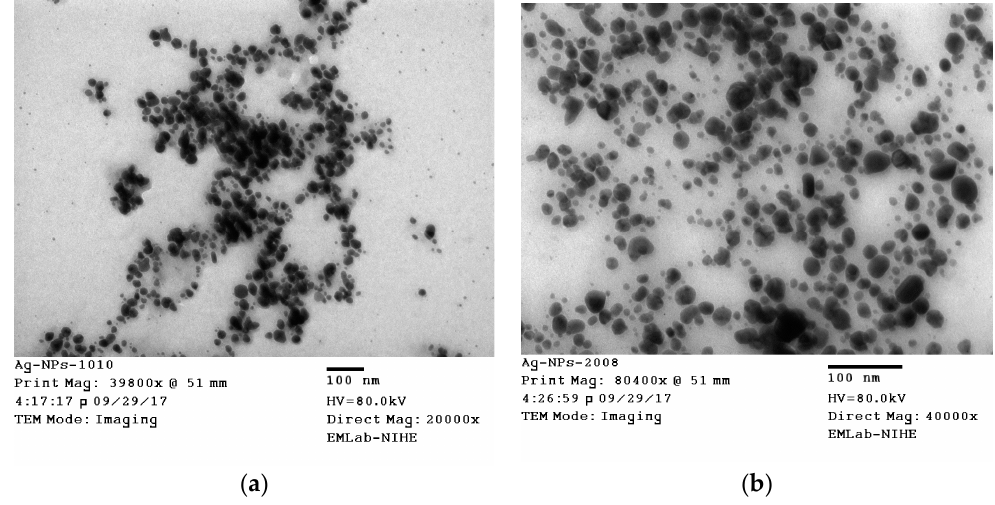
Figure 7. Transmission Electron Microscope (TEM) images of silver nanoparticles (M 8 and M 9 ).